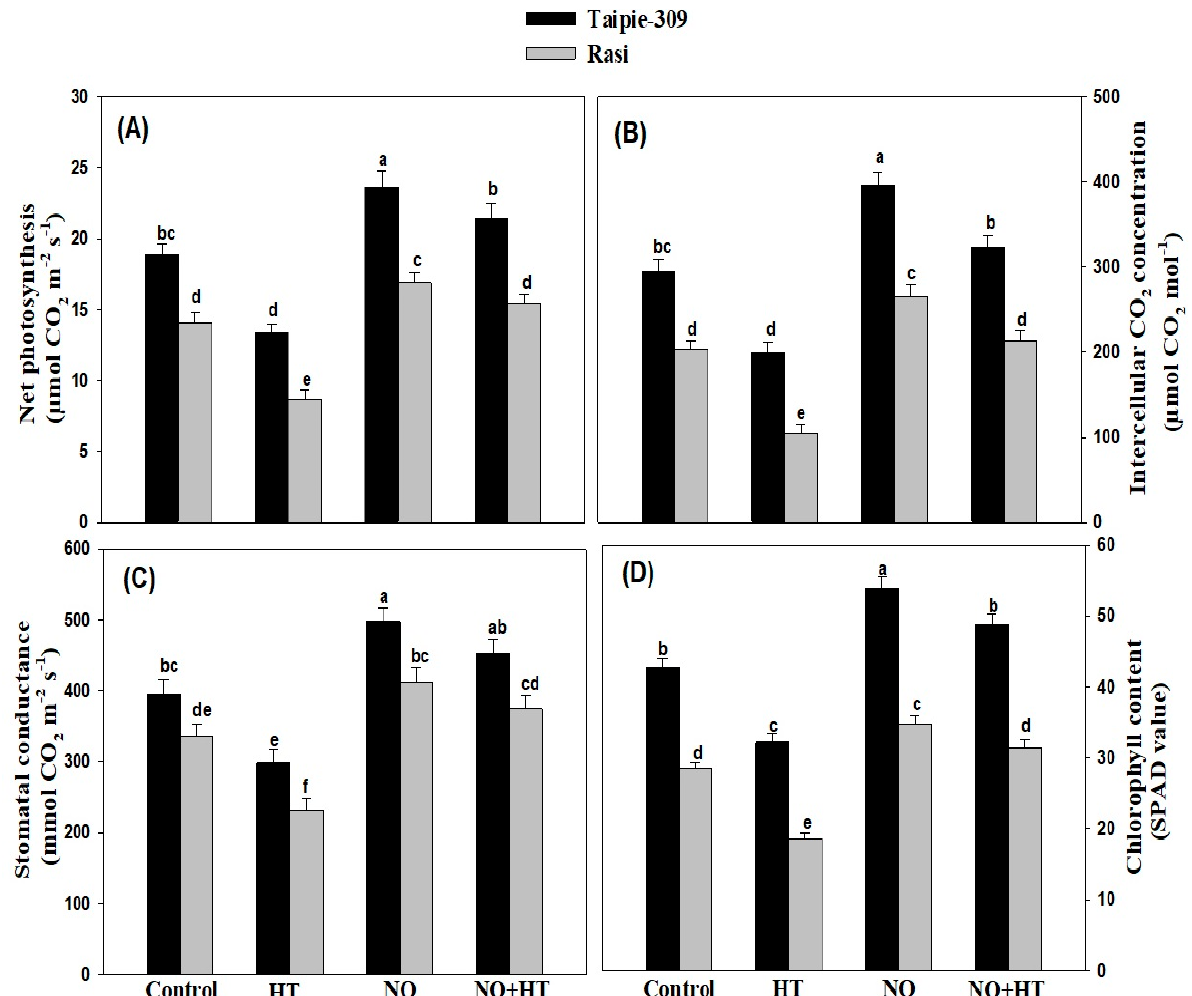
Figure 3. Net photosynthesis ( A ), stomatal conductance ( B ), intercellular CO 2 concentration ( C ), and chlorophyll content (SPAD value) ( D ) in Taipie-309 and Rasi cultivars of rice ( Oryza sativa L.) at 30 days after germination (DAG), plants were grown with/without high temperature stress and treated with foliar 100 µM SNP (NO donor). Data are presented as treatments mean ± SE (n = 4). The values followed by same letters above bars represent that data did not differ significantly by LSD test at p < 0.05.